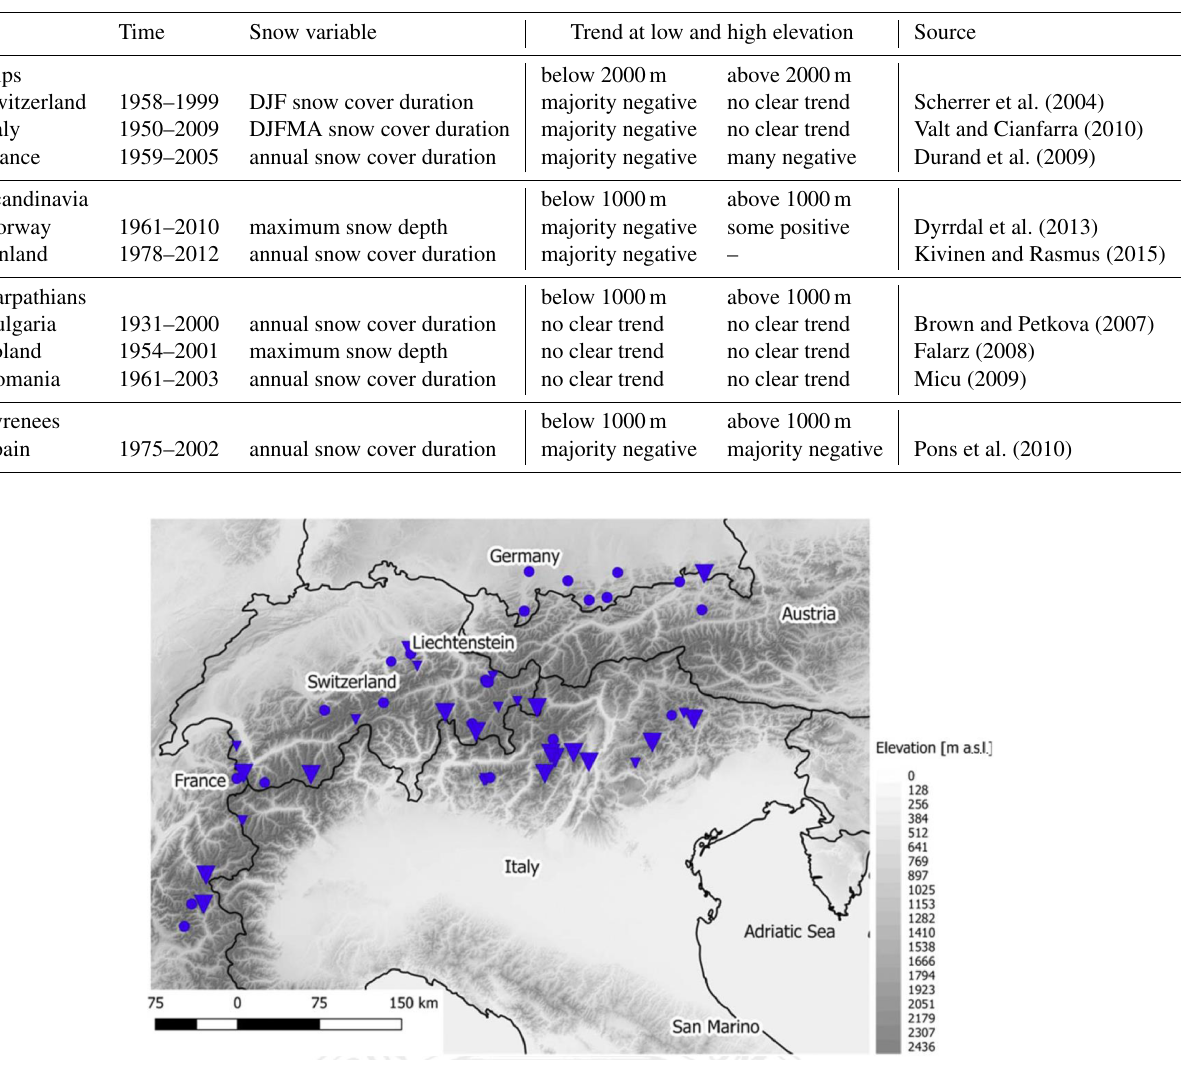
Table 1. Recent studies of current snow cover trends in the major European mountain regions. Only significant trends are listed. Note that a direct comparison of the sites is difficult since the considered time period and snow variable can differ.